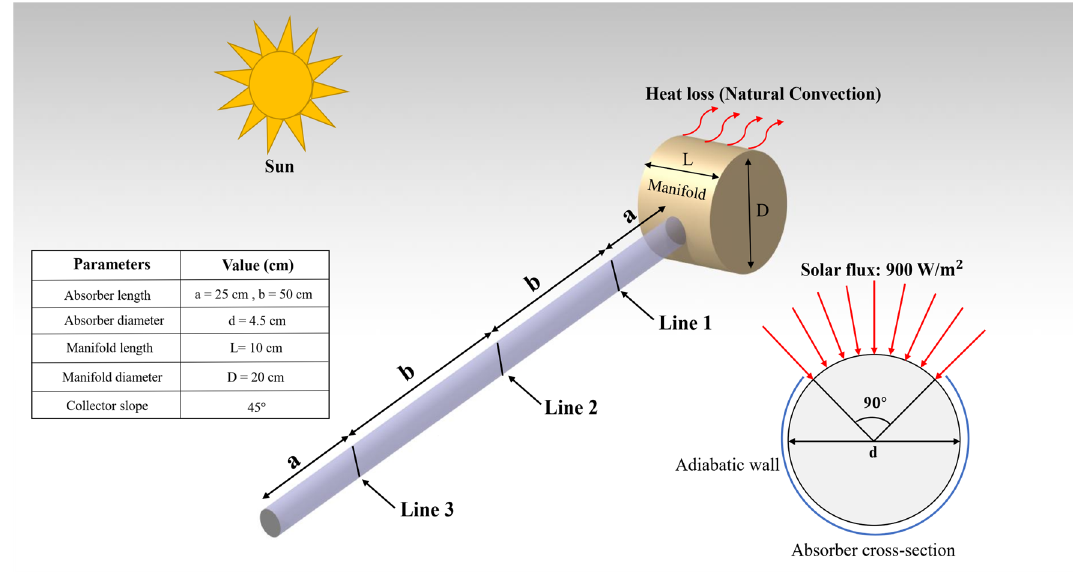
Figure 1. The geometry of the scrutinized solar